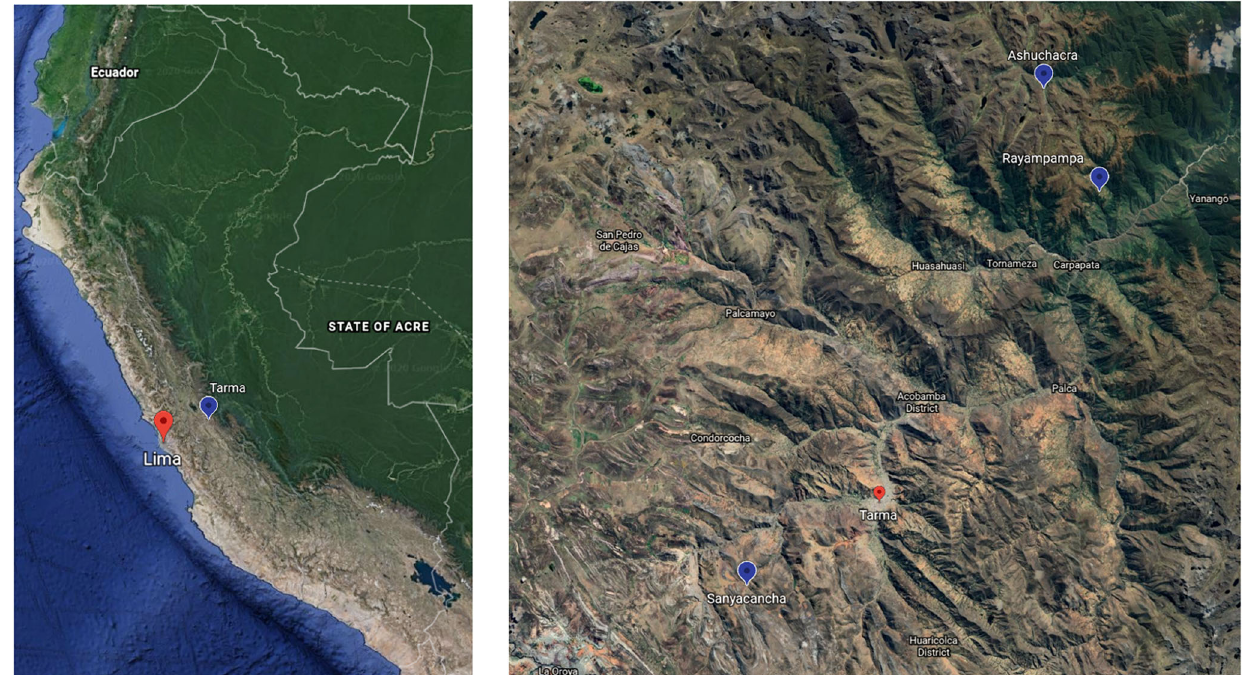
Fig. 1 Map of Peru and the selected communities near Tarma, Department of Junín. This fi gure shows the map of Peru and the location/proximity of the three communities in Tarma, in the central highlands.